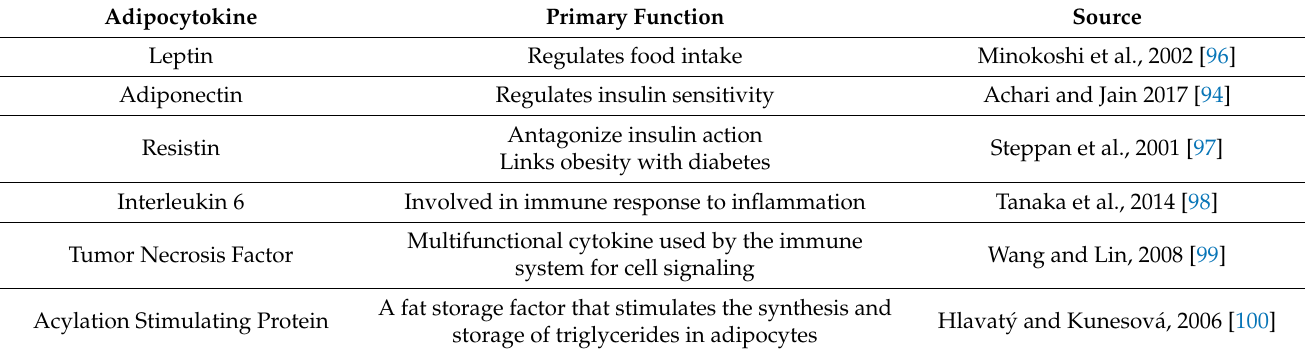
Table 1. Summary of the primary function of key adipocytokines produced by white adipose